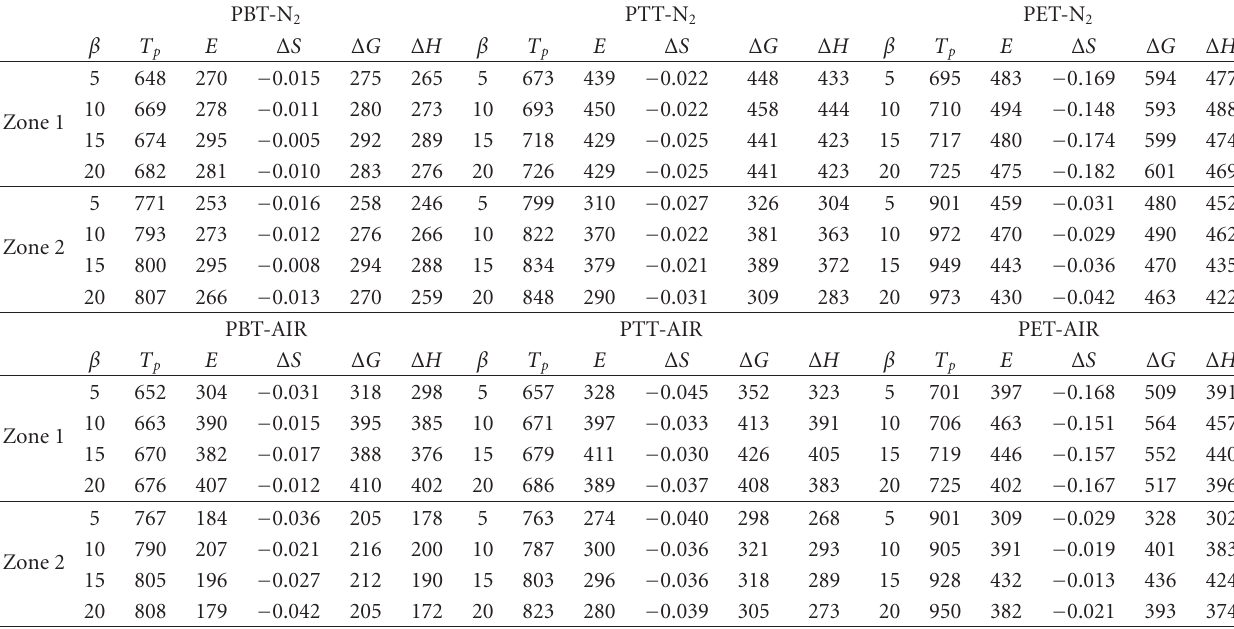
Table 1: Kinetic characteristics of di ff erent polyesters.